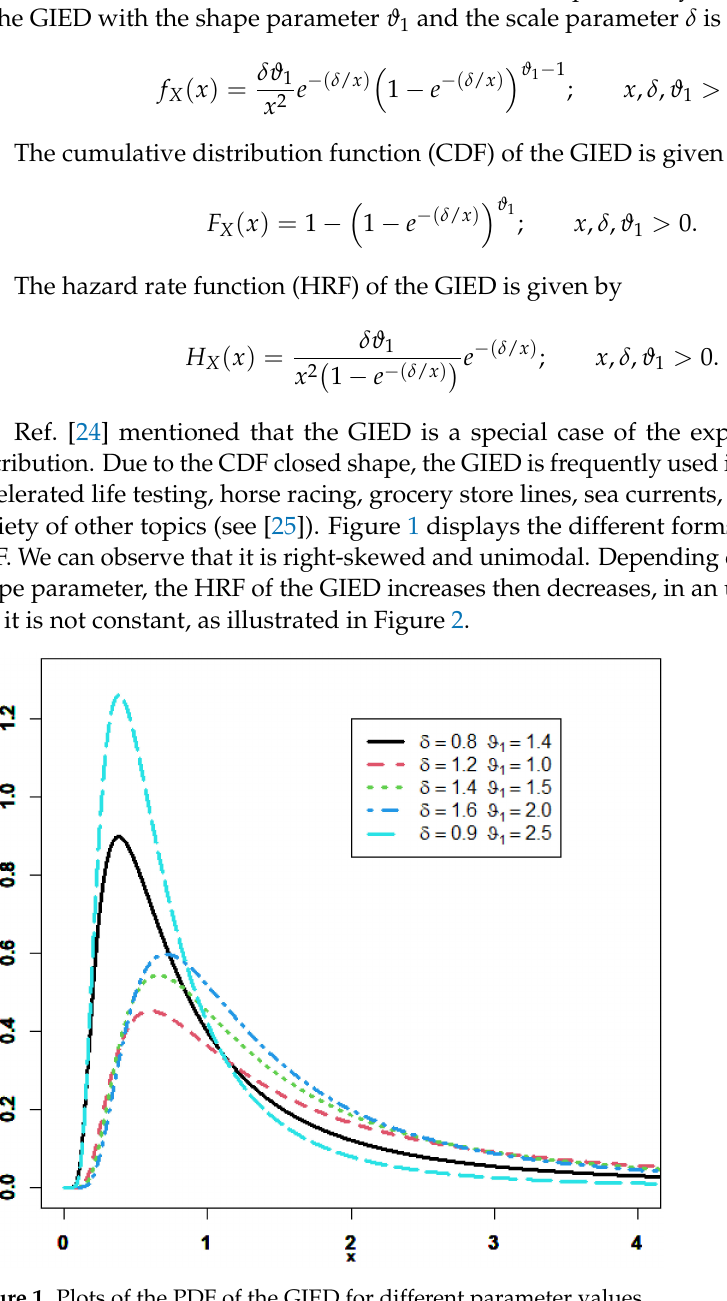
Figure 1. Plots of the PDF of the GIED for different parameter